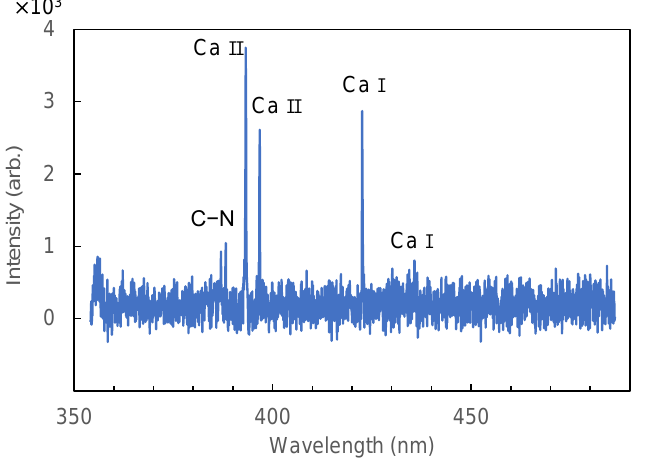
Figure 2. Laser-induced breakdown spectroscopy (LIBS) spectrum of hair measured by a focusing system with a single lens.